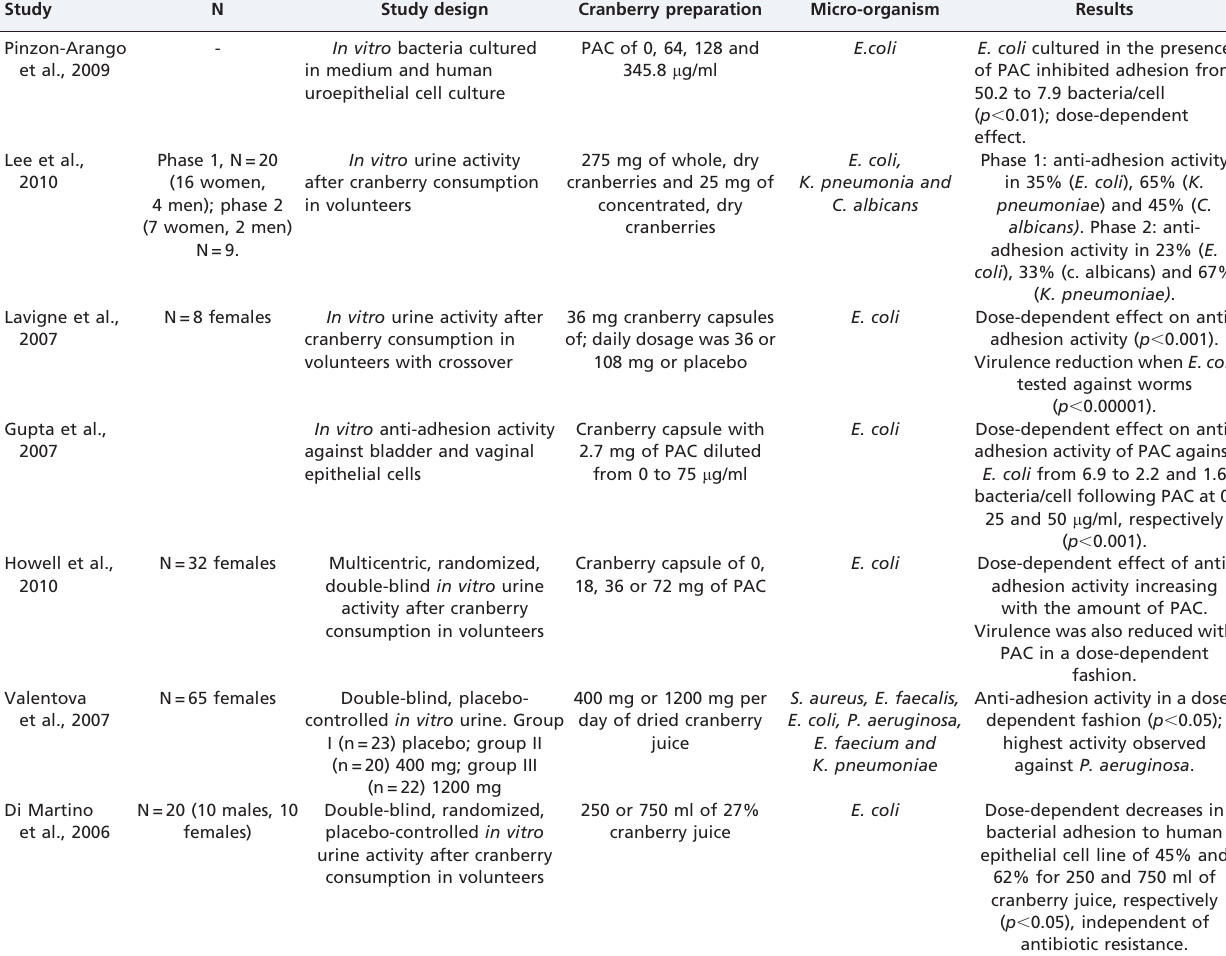
Table 1 - In vitro activity of cranberries against